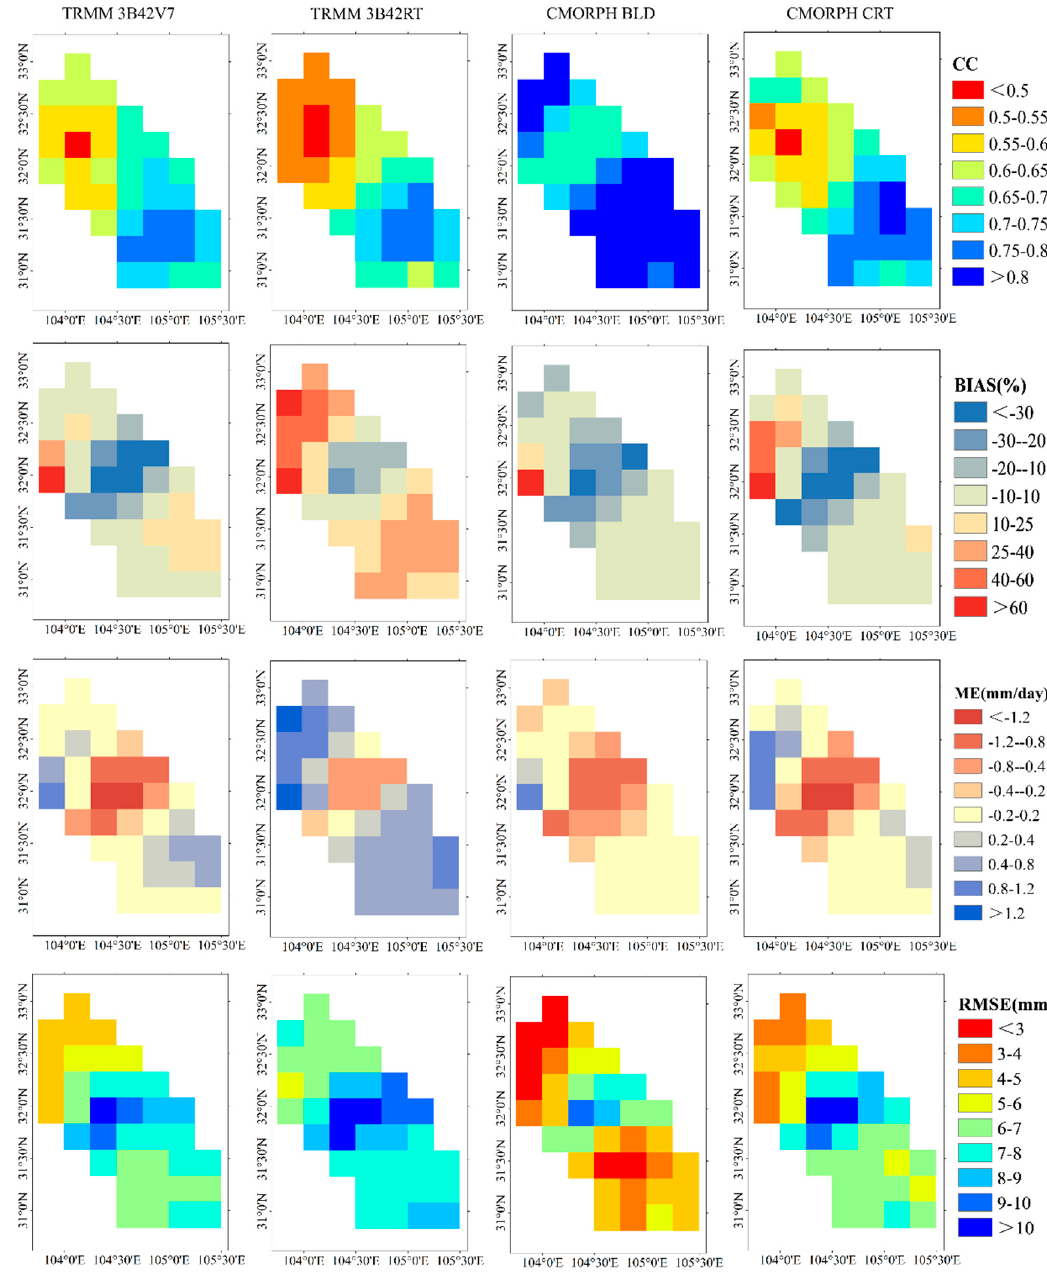
Figure 3. Spatial maps of metrics between the four satellite precipitation products and CGDPA for CC, BIAS, ME and RMSE (from top to the bottom) during 2006–2013.